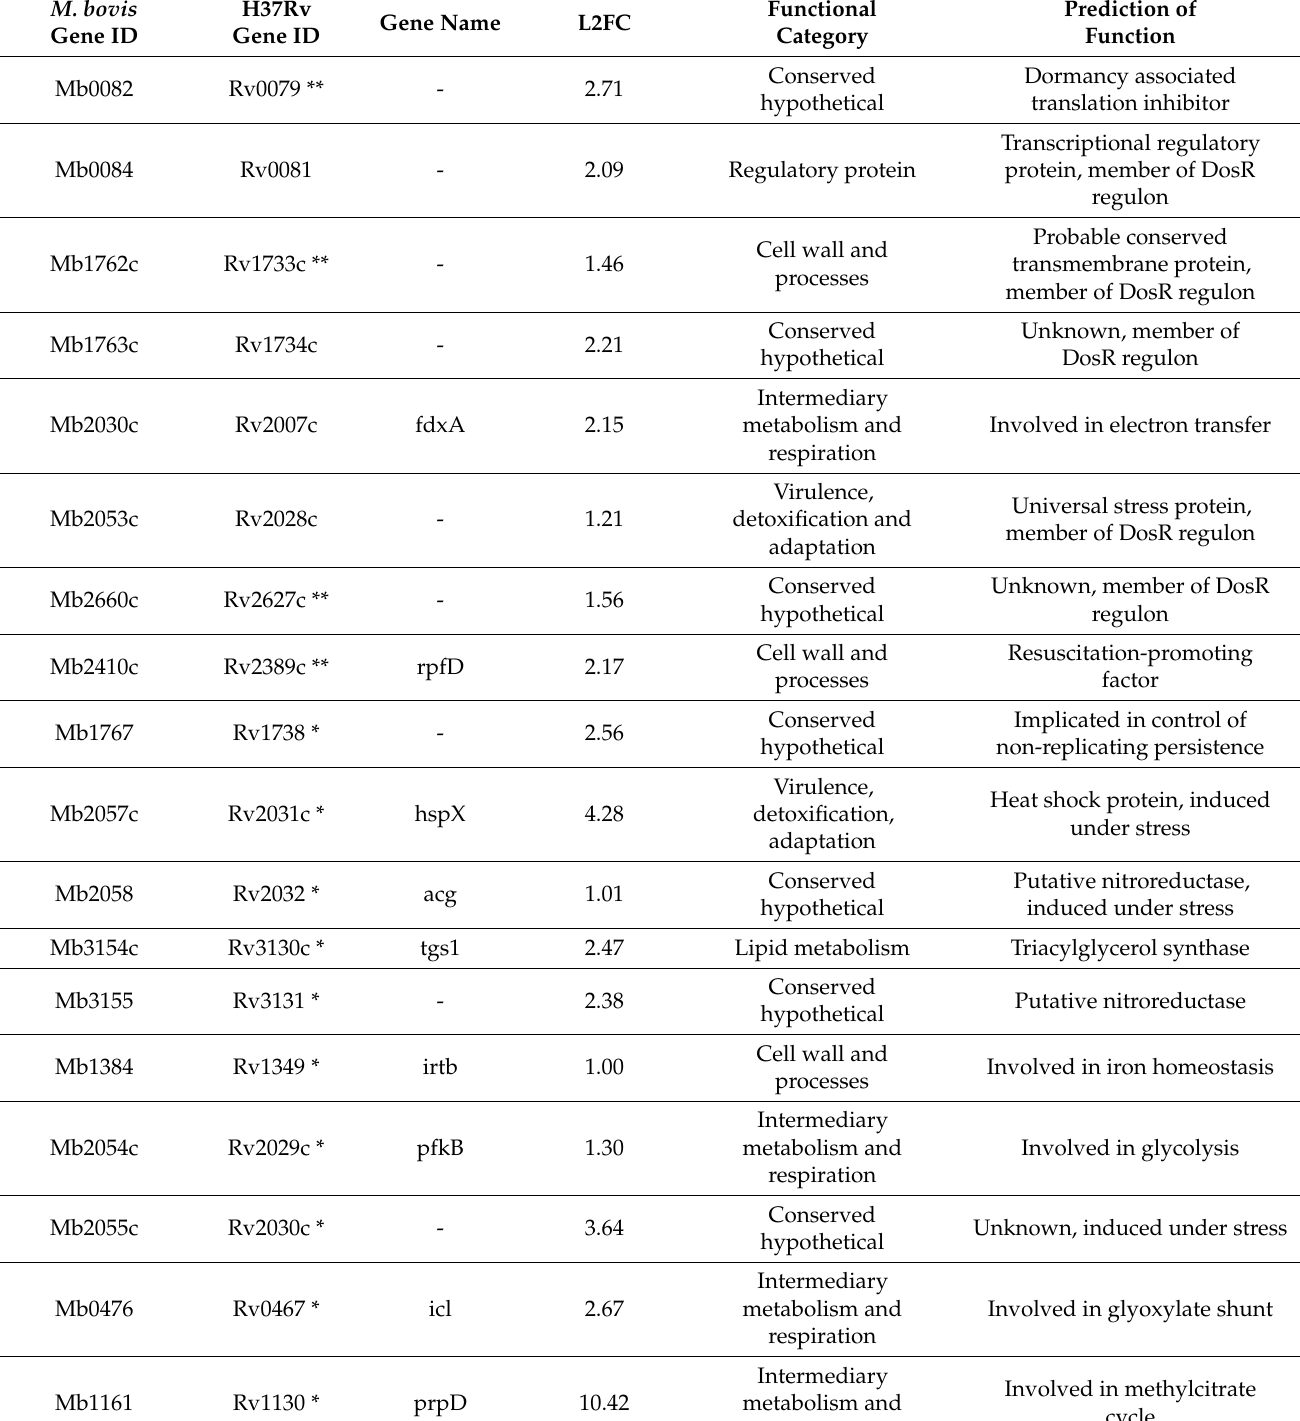
Table 2. Genes induced by M. bovis BCG after macrophage infection relative to in vitro growth that were also demonstrated to be immunogenic in patients with active pulmonary tuberculosis [38] and/or are listed in the top 45 vaccine candidate antigens by Zvi et al. [39]. No asterisk = Kassa et al. [38] only; * = Zvi et al. [39] only; ** = identified in both